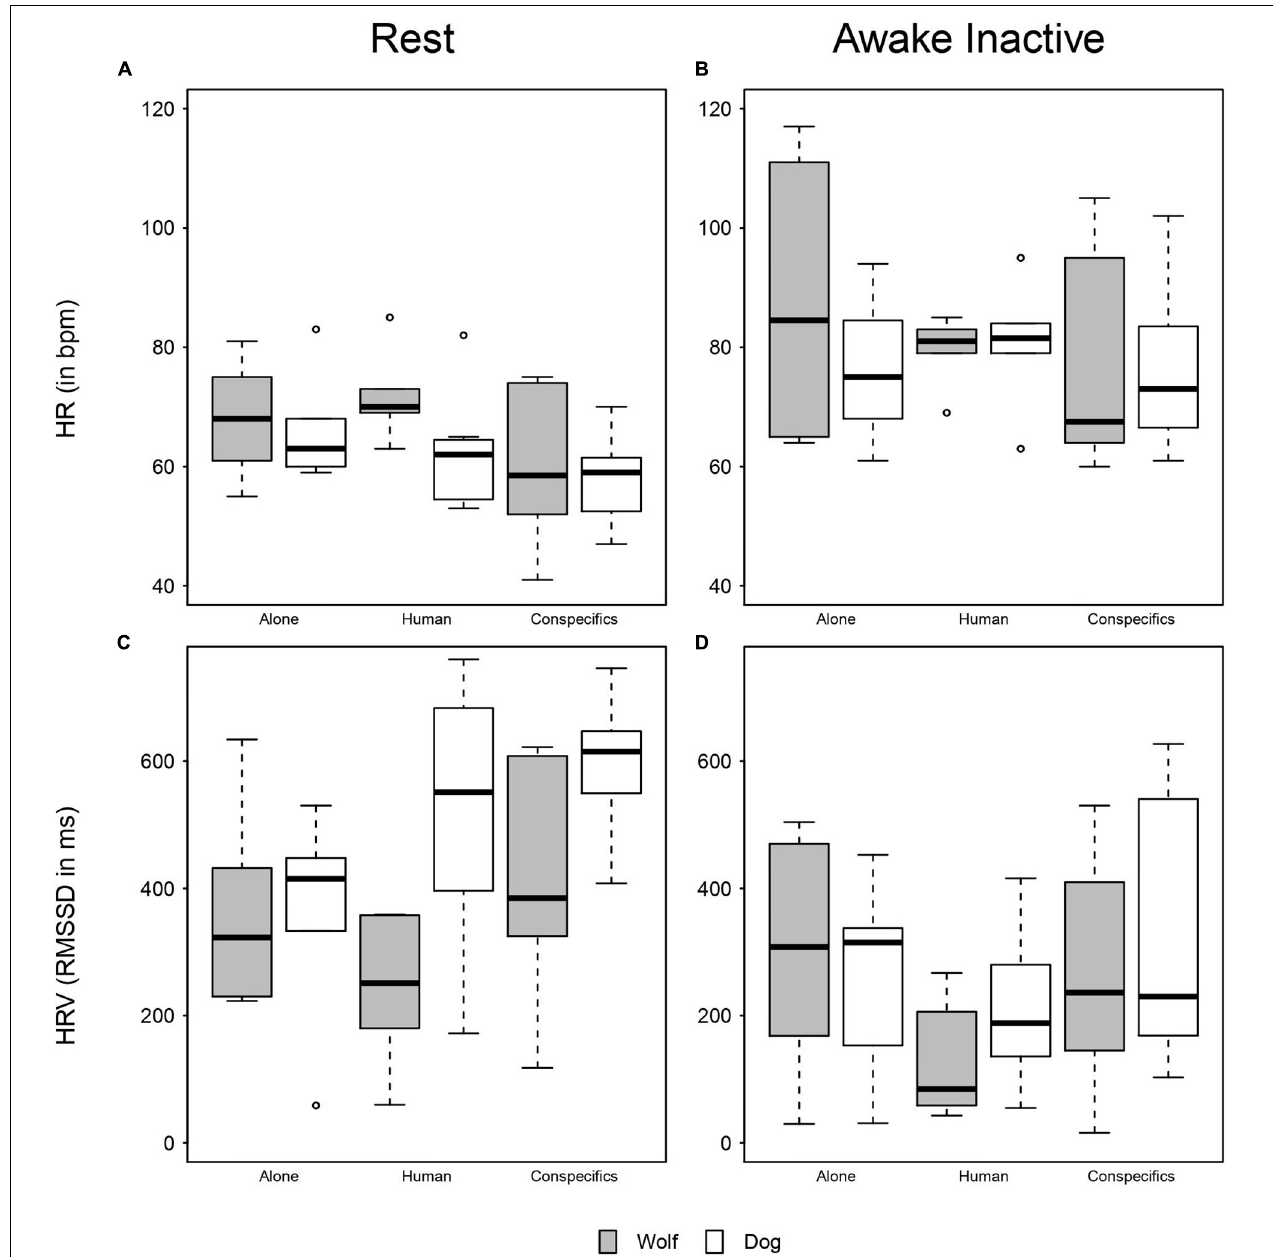
FIGURE 1 | Boxplot of mean HR and HRV. (A) Mean HR of wolves and dogs when resting across conditions. (B) Mean HR of wolves and dogs when awake and inactive across conditions. (C) HRV of wolves and dogs when resting across conditions. (D) HRV of wolves and dogs when awake and inactive across conditions.